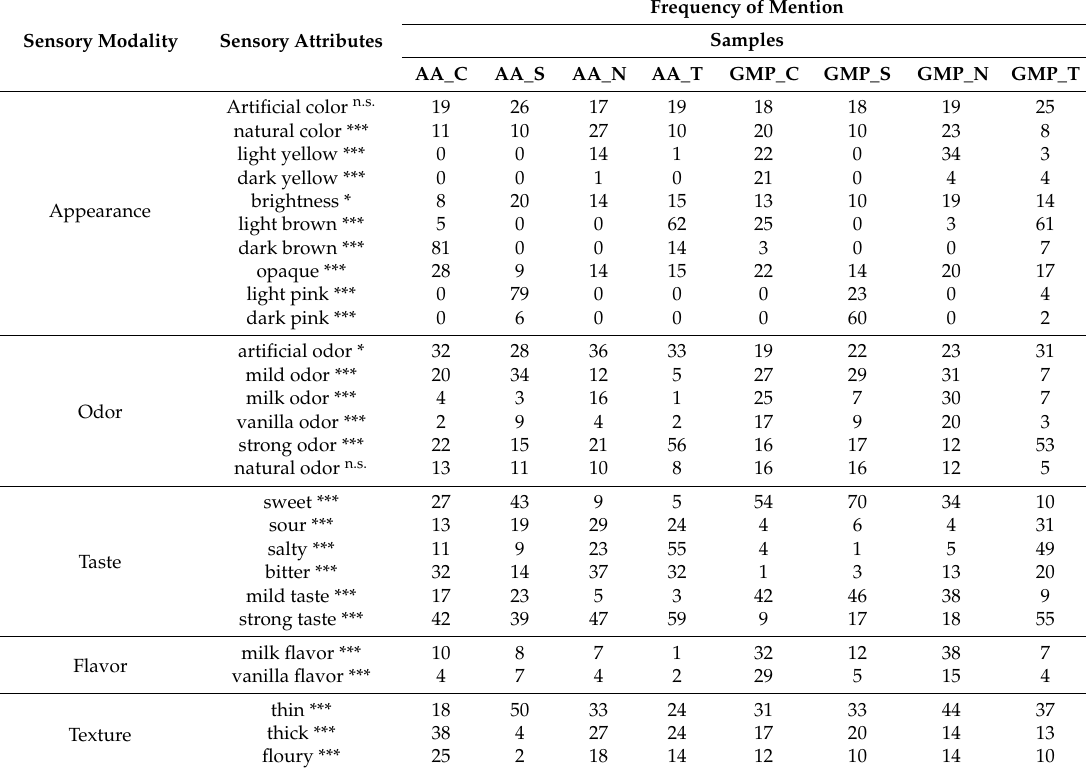
Table 3. Frequency mention of sensory attributes associated with each